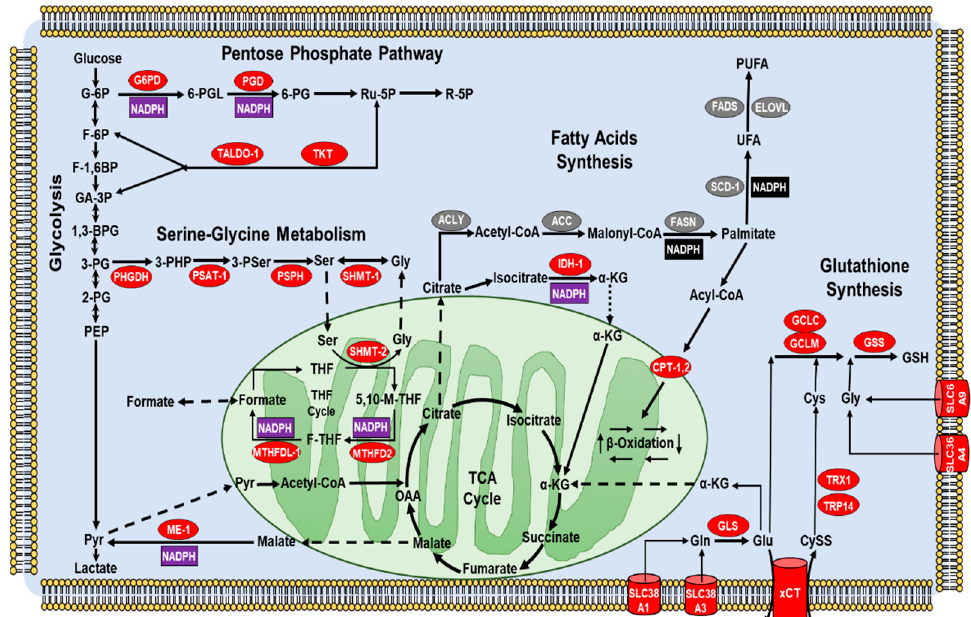
Figure 3. NRF2 rewires cancer cells metabolism to support the redox homeostasis. The enzymes marked in red are positively regulated while those in green are negatively modulated by NRF2.